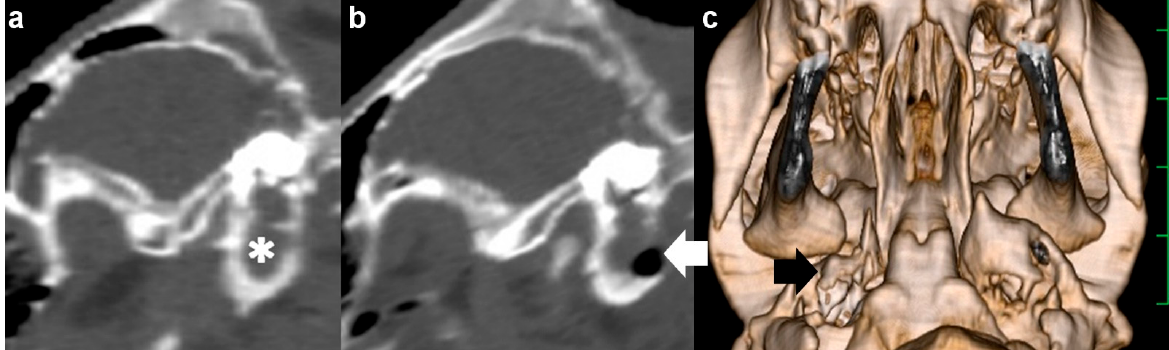
Figure 2. Sagittal computed tomography of the right tympanic bulla as examined preoperatively ( a ) and postoperatively ( b ) in Case 1. ( a ) The hyperattenuating materials (asterisk) are seen within the tympanic cavity. ( b ) A lack of bony structure (arrow) is seen in the entire caudal wall of the tympanic cavity. ( c ) Three-dimensional computed tomography showing the ventral surface of the skull in Case 1. A perforation (arrow) is made in the entire caudal wall of the tympanic cavity. The scale is 25 mm. Table 1. Computed tomographic measurements of tympanic bulla in three cases with otitis media and healthy calves.